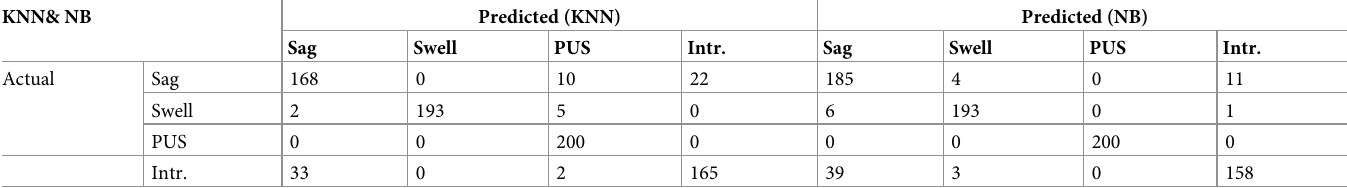
Table 4. Confusion matrices for the KNN and the NB classifiers.